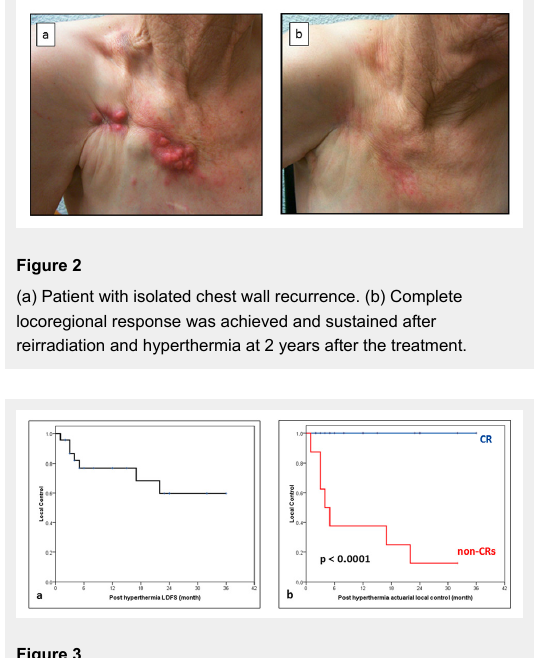
(a) Actuarial local control for all patients of recurrent breast cancers following reirradiation and hyperthermia. (b) Actuarial local control in complete responders (CRs) vs non-CRs (p <0.001). LDFS = local disease-free survival